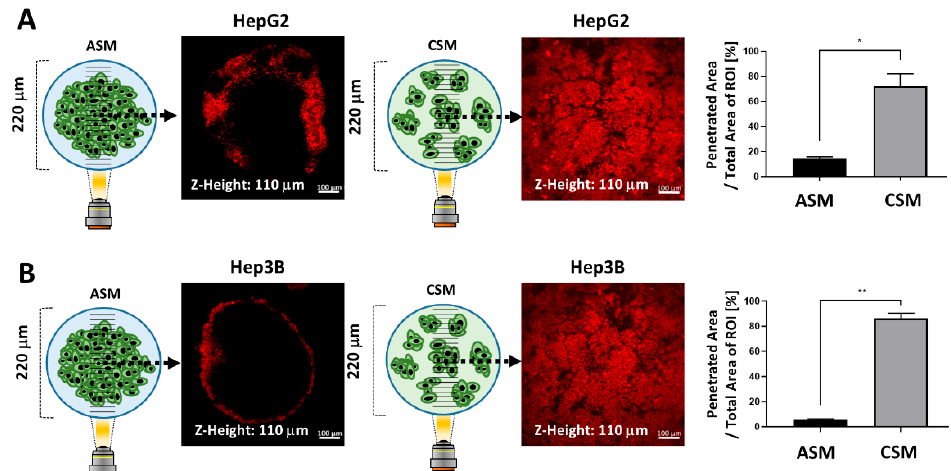
Figure 6. Drug penetration assay for validation of drug resistance in the ASM using the auto-fluorescent drug (DOX). ( A ) Images of DOX penetration in HepG2 ASM and CSM and quantitatively analyzed drug penetration ratios in each 3D model. The penetrated DOX fluorescence was calculated at 14.69% and 72.2%, respectively. ( B ) Images of DOX penetration in HepG2 ASM and CSM and quantitatively analyzed drug penetration ratios in each 3D model. The penetrated DOX fluorescence was calculated at 5.75% and 86.37%, respectively. * p < 0.05, ** p < 0.01. The penetrated DOX fluorescence was detected at 14.69% and 72.2% in the HepG2 ASM and CSM respectively (Figure 6A). In the Hep3B ASM and CSM, the penetrated